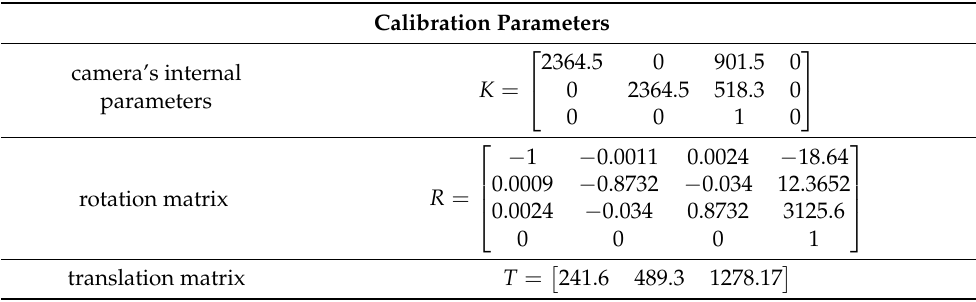
Table 1. Calibration table of camera parameters.